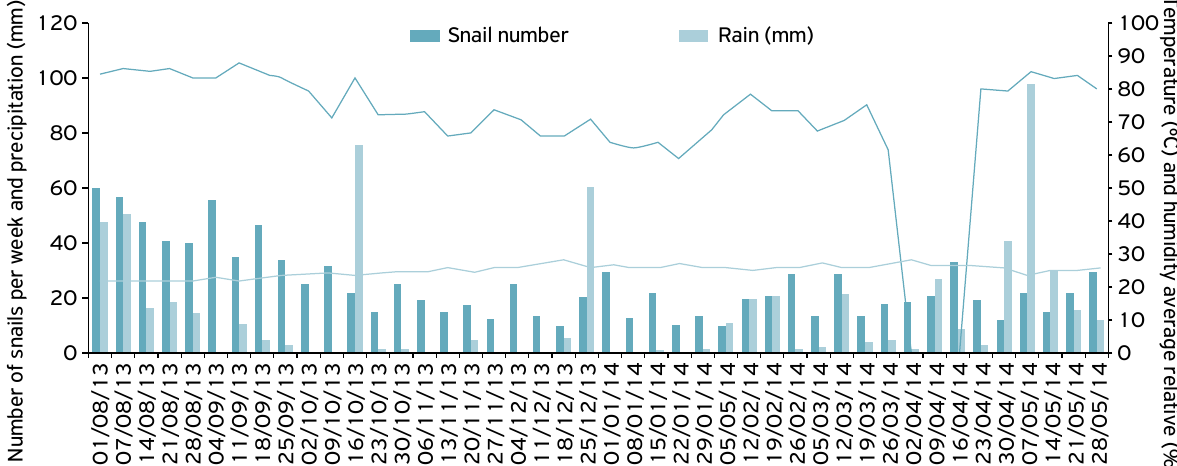
Figure 2. Weekly variation of adult of Achatina fulica collected from August 2013 to May 2014 in lettuce area ( Lactuca sativa L.), in the location of Bálsamo, Arapiraca, Alagoas, Brazil.